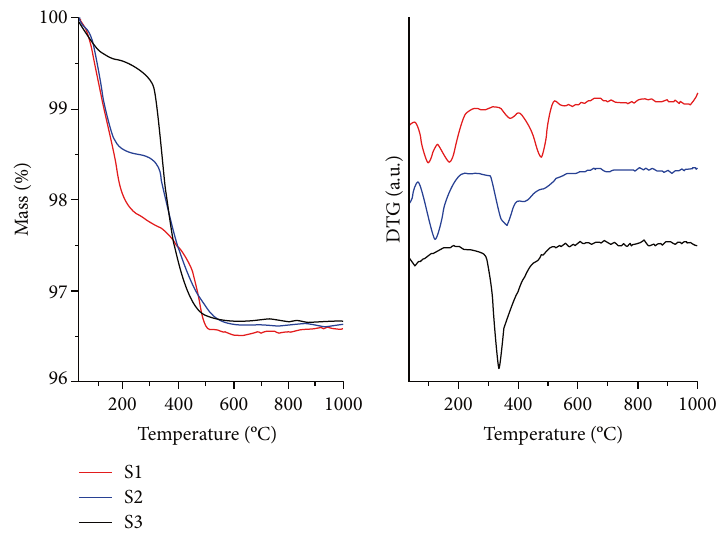
La Ti O samples S1, S2, and S3. 2 2 3 10